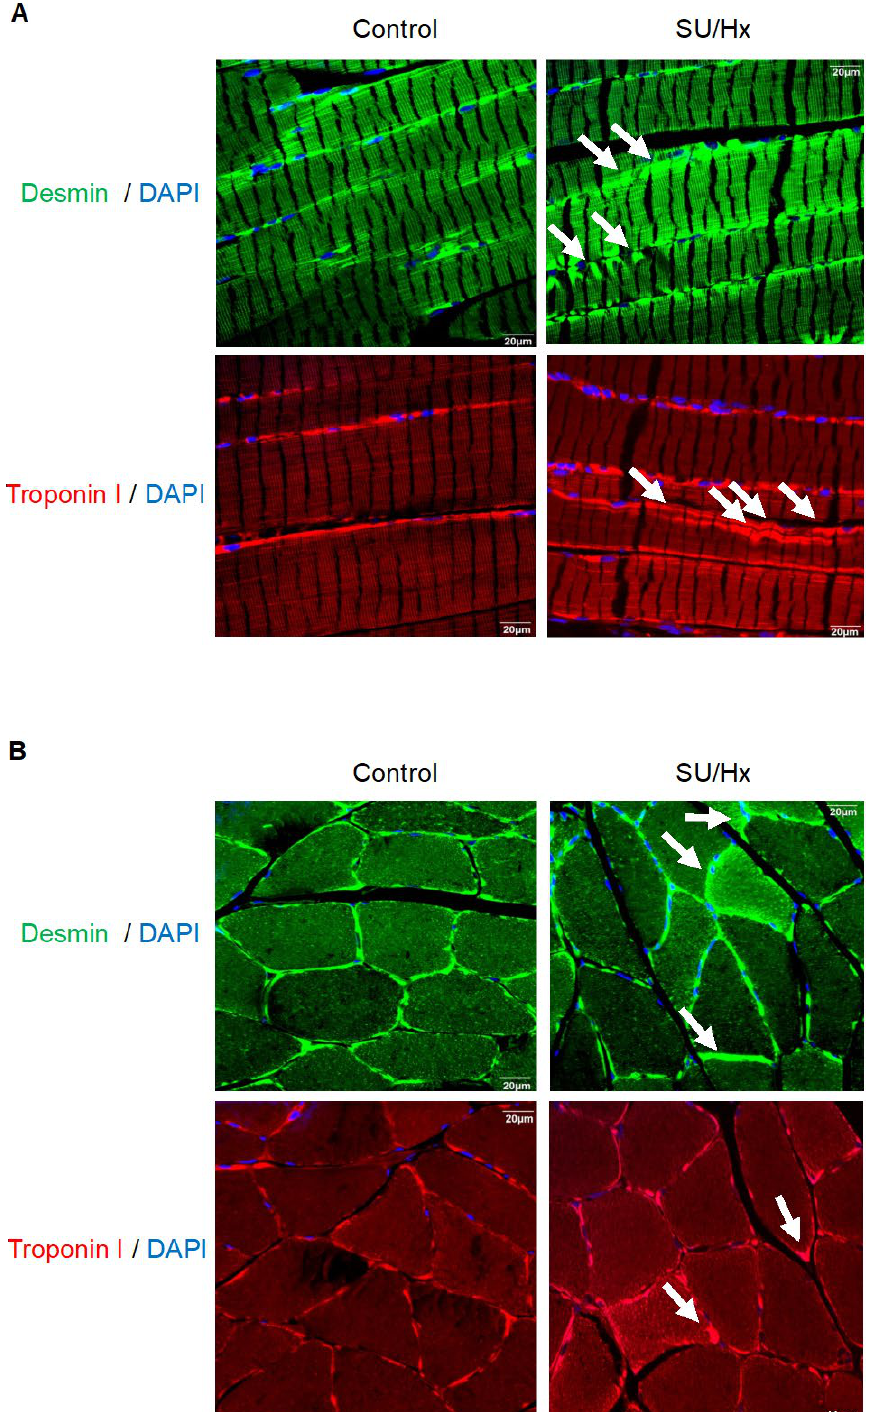
Figure 3. ( A ) Paraffin-embedded longitudinal sections of soleus muscle that is stained with desmin (Z-disc) and troponin-I specific antibodies showing a compromised and disorganized sarcomeric organization with aggregate-like structures (arrows) in SU/Hx-induced PH rats when they are compared to those of the controls. ( B ) Thick transverse desmin aggregates along the sarcolemma (arrows) and an assembly of troponin components along the sarcolemma (arrows) in transverse cryosections of soleus from animals with SU/Hx-induced PH is seen, and these are compared to those of the controls. Immunofluorescence microscopy with desmin and troponin-I specific antibodies, respectively. Nuclei are visualized after DAPI staining. Scale bar, 20 μm. n = 3 animals per group.